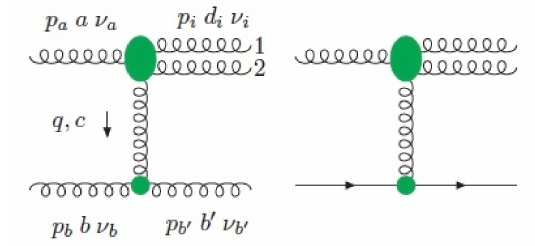
Figure 5 . Tree ( a ) five-gluon amplitude for the g a g b → g 1 g 2 g b 0 scattering, and ( b ) two-quark three-gluon amplitude for the g a q b → g 1 g 2 q b 0 scattering, in the NMRK of eq. (2.1). The oval blob represents the impact factor for the emission of two